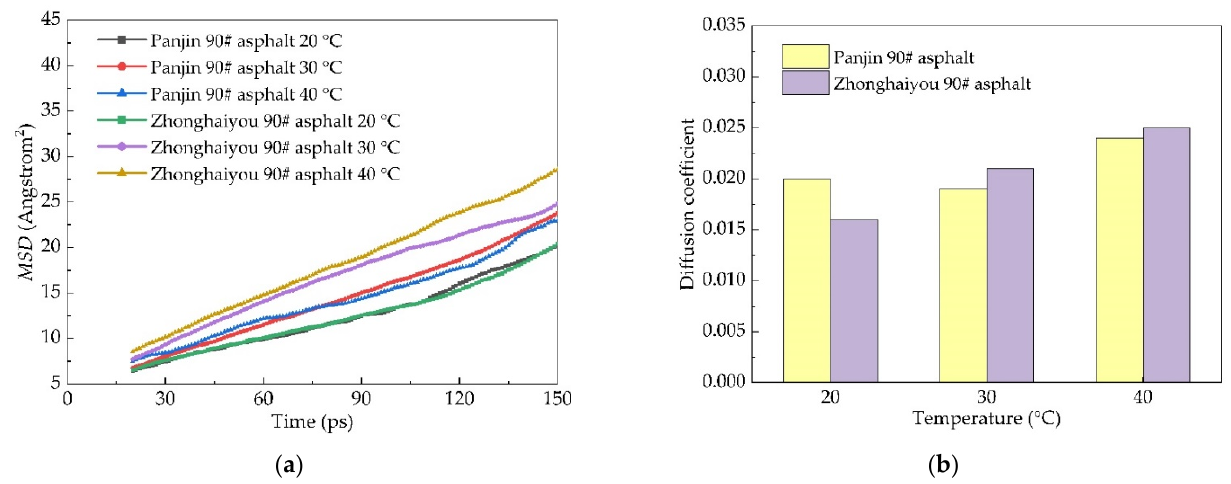
Figure 9. Comparison diagram of two asphalt MSD diagram and diffusion coefficient: ( a ) the dependence of MSD as a function of time and ( b ) the dependence of diffusion coefficient as a function of temperature.